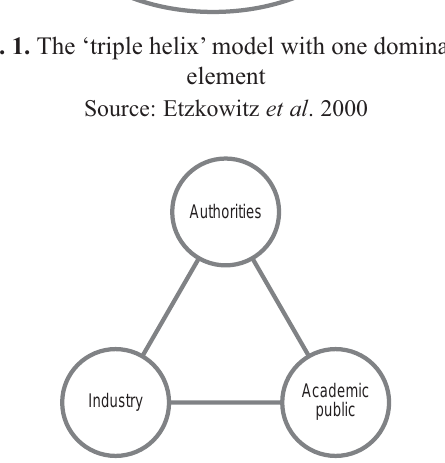
Fig. 2. The ‘triple helix’ model of mutual relations Source: Etzkowitz et al . 2000